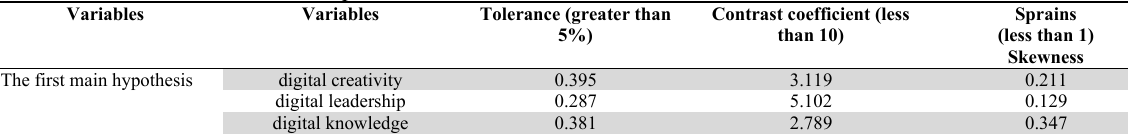
Test the variance inflation factor, the permissible variance, and the skew modulus Variables Variables